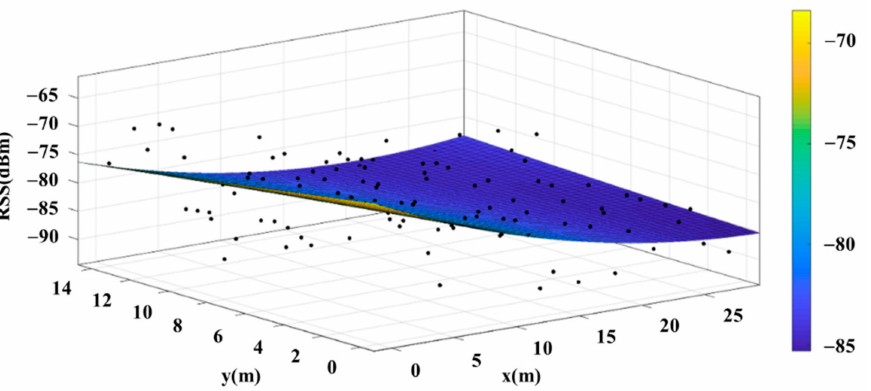
Figure 25. Model Generated Using Surface Normalizing